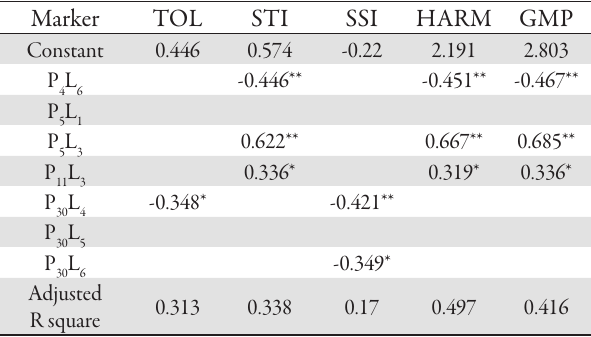
Tab. 6. Regression coefficients between markers and drought tolerance indices in 2/3 continuous irrigation